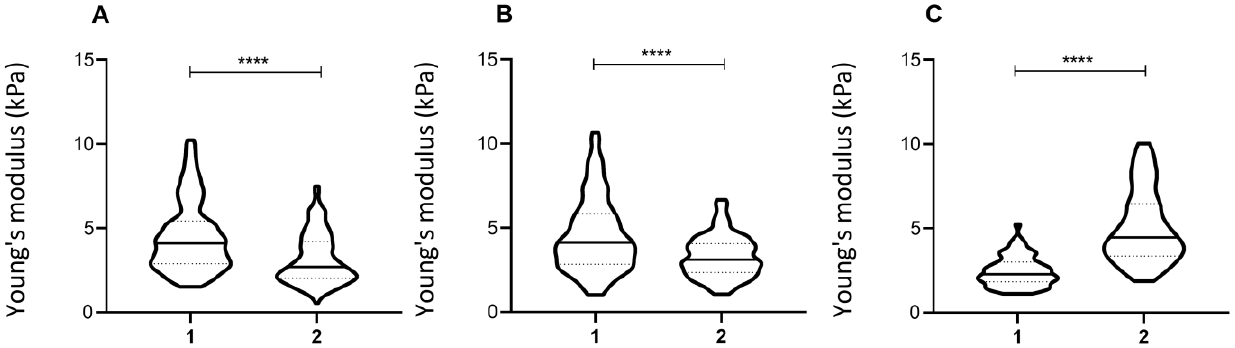
Figure 4. Young’s modulus of biological replicates. The graphs show the distribution of single-cell Young’s modulus, from three different fibroblast lines, each evaluated starting from two different cryotubes (line 1 in panel ( A ), line 2 in panel ( B ), line 3 in panel ( C )). The non-parametric Kolmogorov– Smirnov test was applied to assess the statistical significance (**** p < 0.0001).